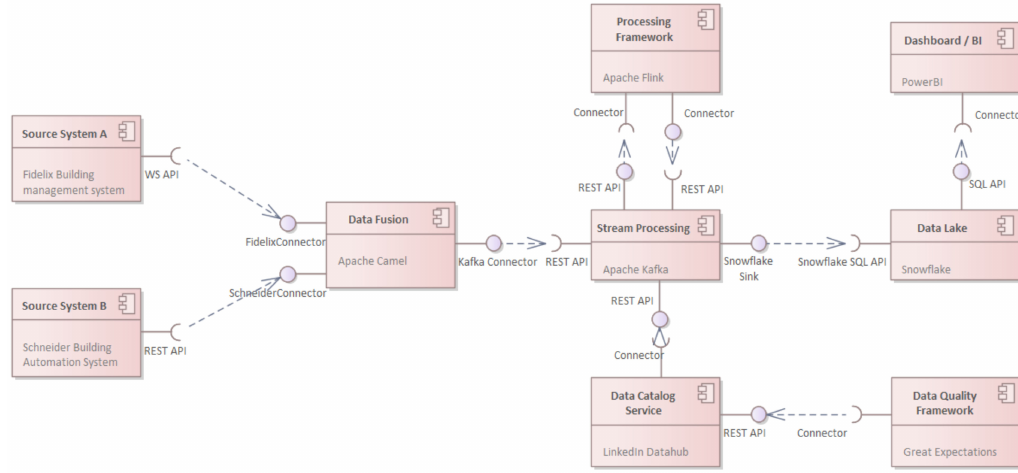
Figure 2. Component diagram for use case building automation